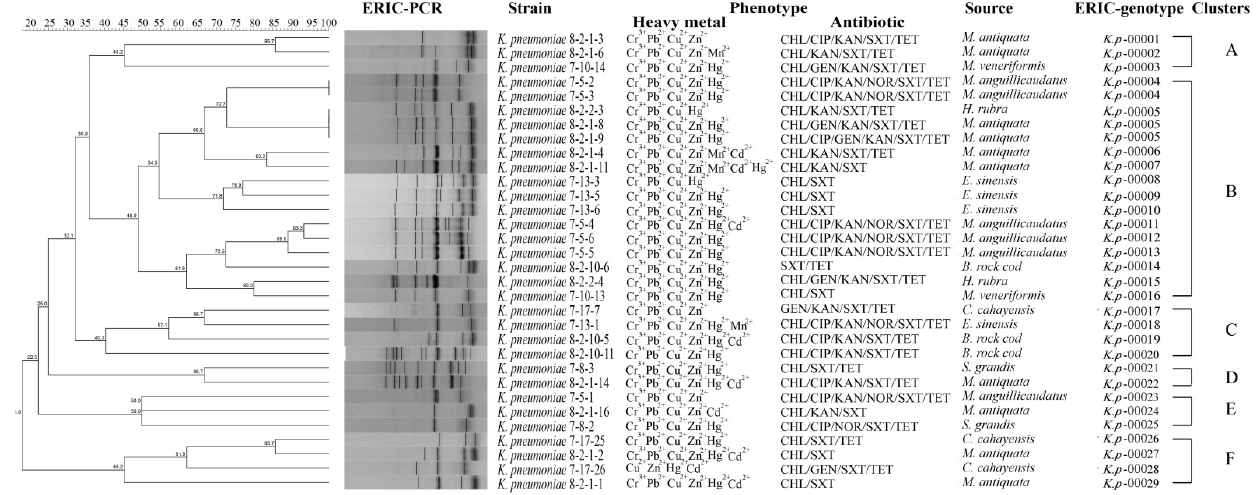
Figure 3. The ERIC-PCR-based genotyping of the 32 K. pneumoniae strains with MDR phenotypes. Approximately 33.0% ( n = 31) of the 94 K. pneumoniae strains shared 13 ERIC geno- Approximately 33.0% ( n = 31) of the 94 K. pneumoniae strains shared 13 ERIC types. Among these, 12 strains were recovered from C. cahayensis; 9 from P. clarkii ; and 10 from B. rock cod , M. anguillicaudatus , M. antiquata , N. cumingi Crosse , H. rubra , and S. stric- tus . Additionally, three ERIC genotypes contained the strains isolated from different spe- cies of aquatic animals. For instance, three strains sharing ERIC genotype K. p 00023 were isolated from H. rubra ( K. pneumoniae 8-2-2-3) and M. antiquata ( K. pneumoniae 8-2-1-8 and 8-2-1-9). Similarly, ERIC genotype K. p 00046 ( n = 4) was shared by the K. pneumoniae 7-17- 1, 7-17-2, 7-17-16, and 8-1-12-14 strains, which were isolated from C. cahayensis and P. clarkii . ERIC genotype K. p 00057 was shared by K. pneumoniae 8-1-12-1 and 7-8-2 strains